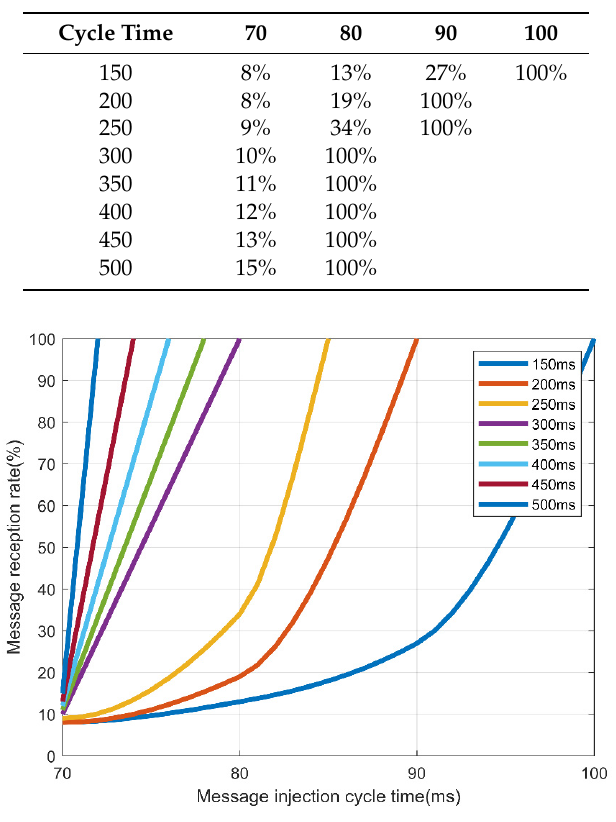
Figure 12. Reception rate by the message injection rate and message transmission cycle in format-preserving encryption (FPE)-FF1.